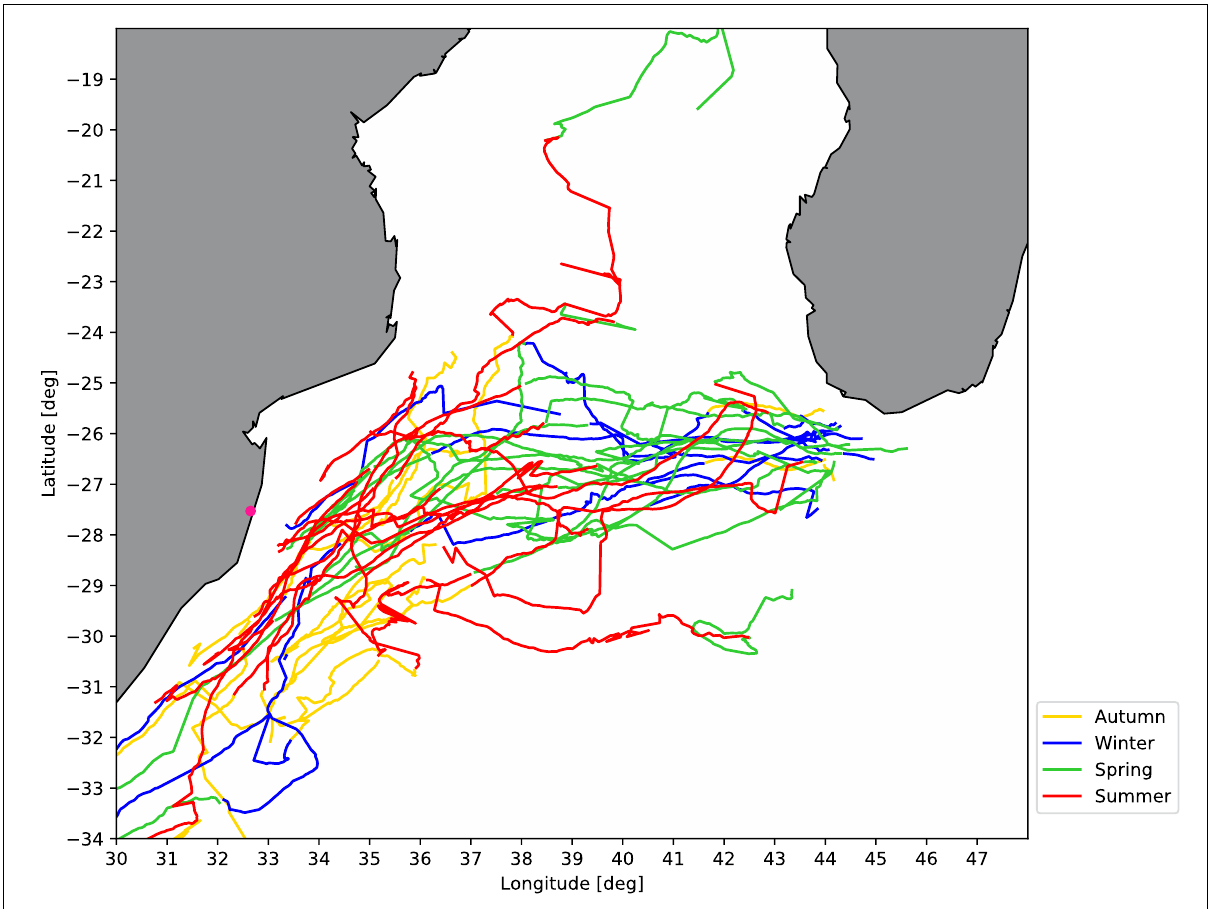
Figure 10: Cyclonic eddy trajectories that passed the Sodwana region during the temperature